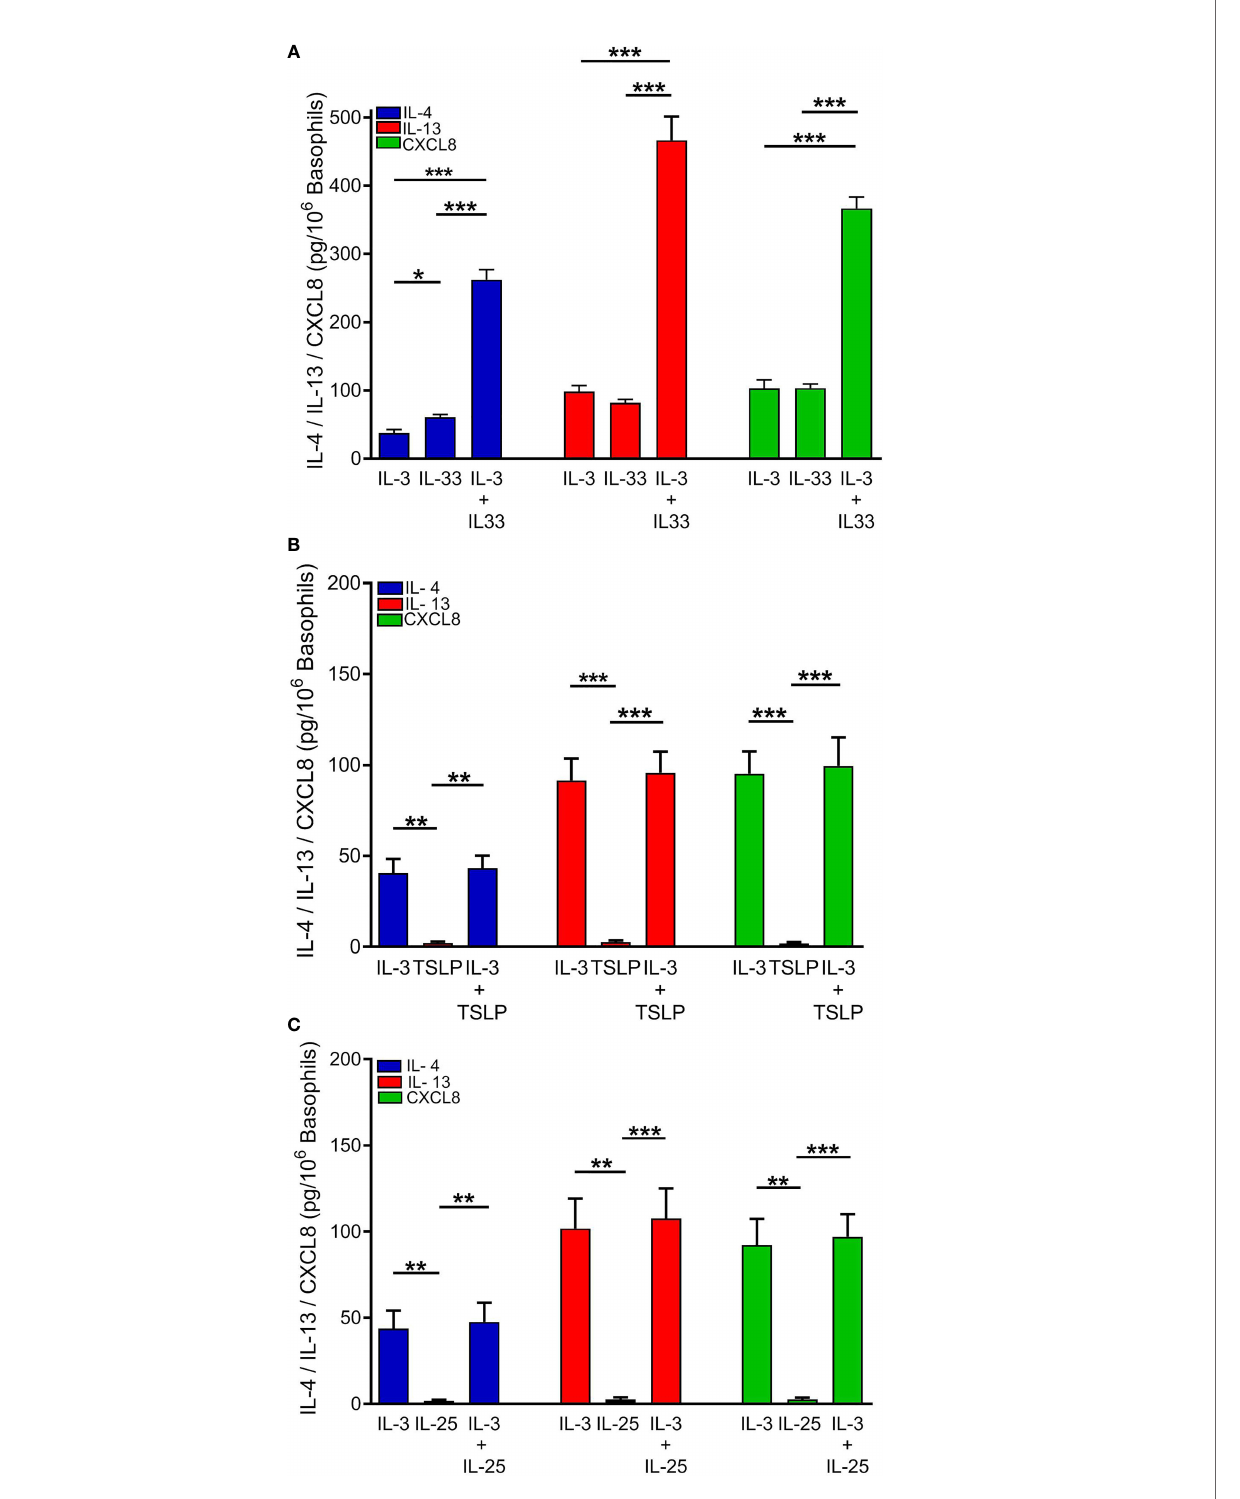
FIGURE 2 | Effects of rhIL-3 (10 ng/ml), alone and in combination with (A) rhIL-33 (10 ng/ml), (B) rhTSLP (10 ng/ml), or (C) rhIL-25 (10 ng/ml), on IL-4, IL-13, and CXCL8 released from different preparations of human basophils (n = 4). Basophils were incubated (18 hours at 37°C) with the indicated concentrations of cytokines. At the end of incubations, cell-free supernatants were collected and analyzed for IL-4, IL-13, and CXCL8 protein by ELISA. * p < 0.05; ** p < 0.01; *** p <